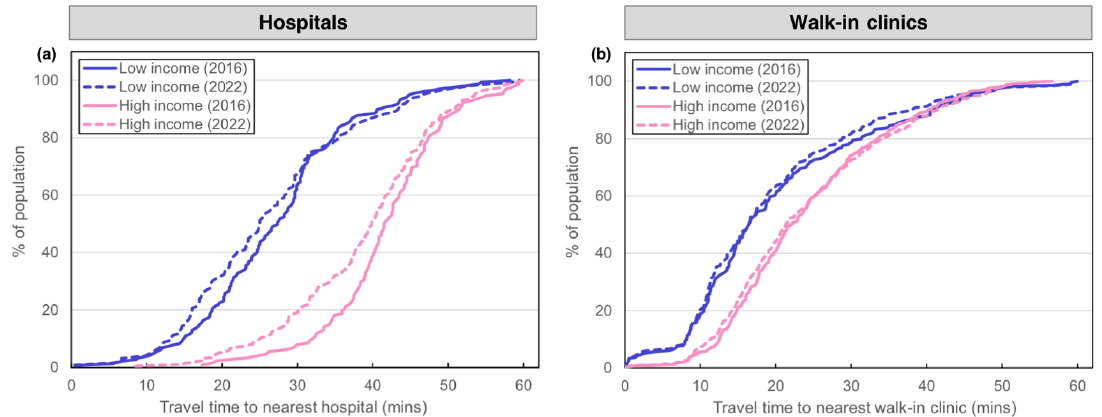
Figure 6. Cumulative frequency distributions of travel-time to closest ( a ) hospital and ( b ) walk-in clinic for each cell in 2016 and 2022, grouped into low (clusters 4 and 8) and high (clusters 1 and 5) income.